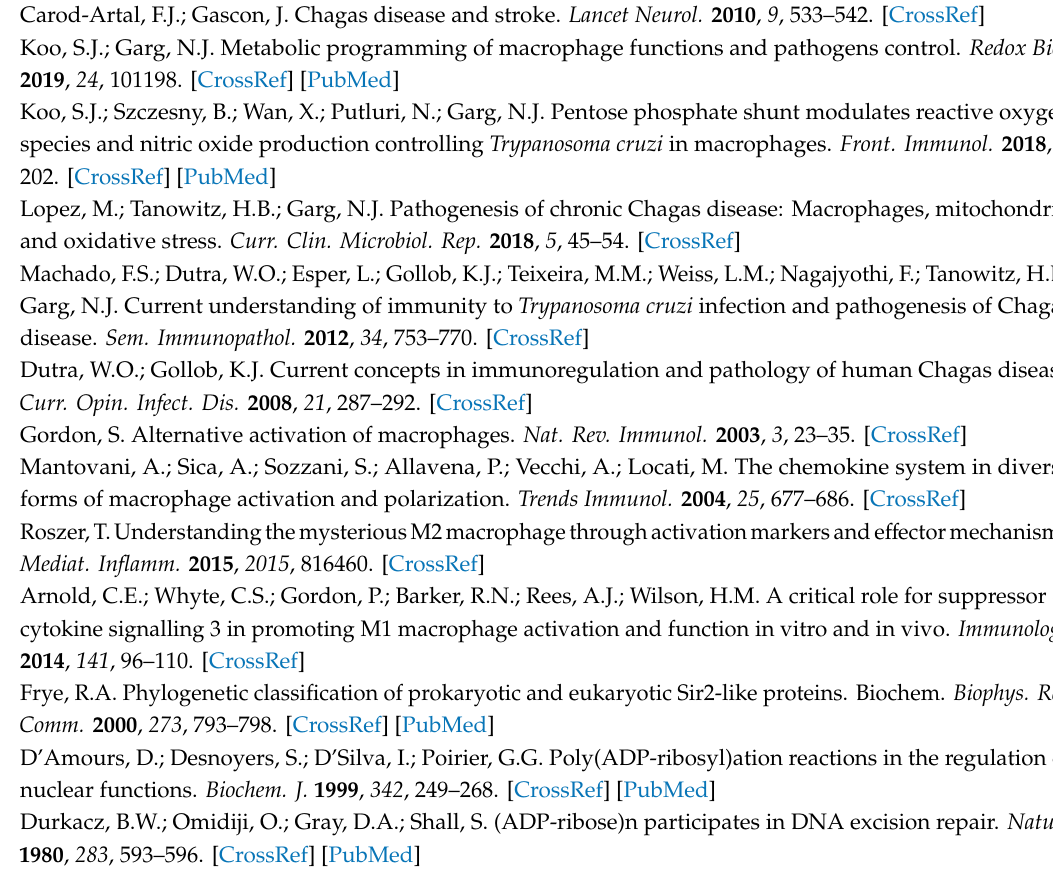
Figure S1: Splenic characterization of HSC monocytes in Chagas mice, Table S1: List of antibodies used in this study, Table S2: Oligonucleotides used in this